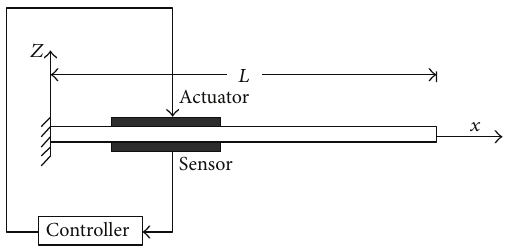
Figure 1: An overhung beam with typical piezoelectric